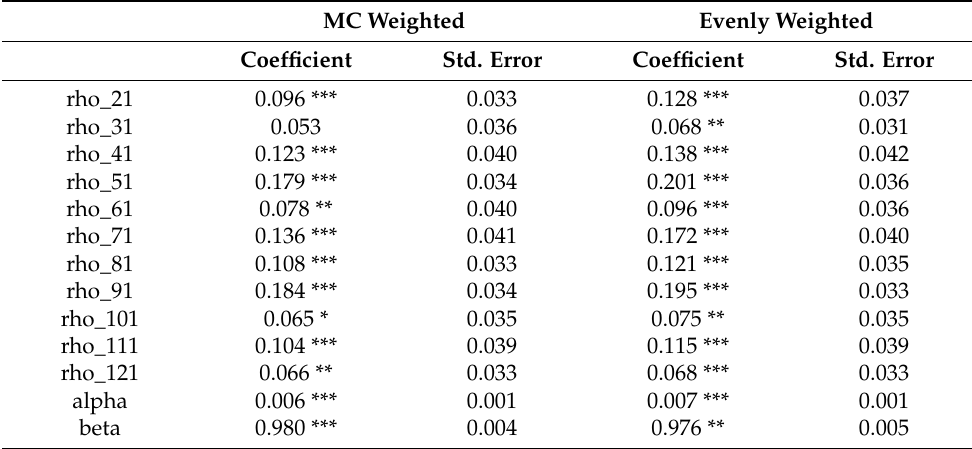
Table A1. DCC-FIGARCH model for SHC and indices